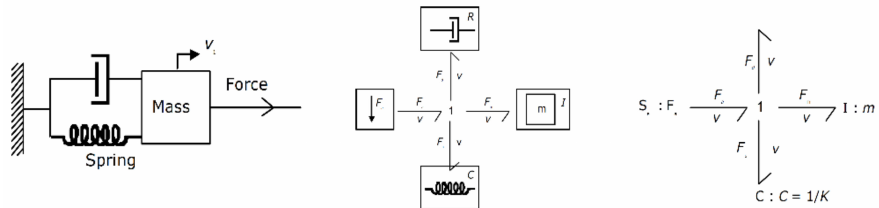
Figure 1. The following figure shows the structure of a mechanical model on the left and the Bond Graph model on the right.